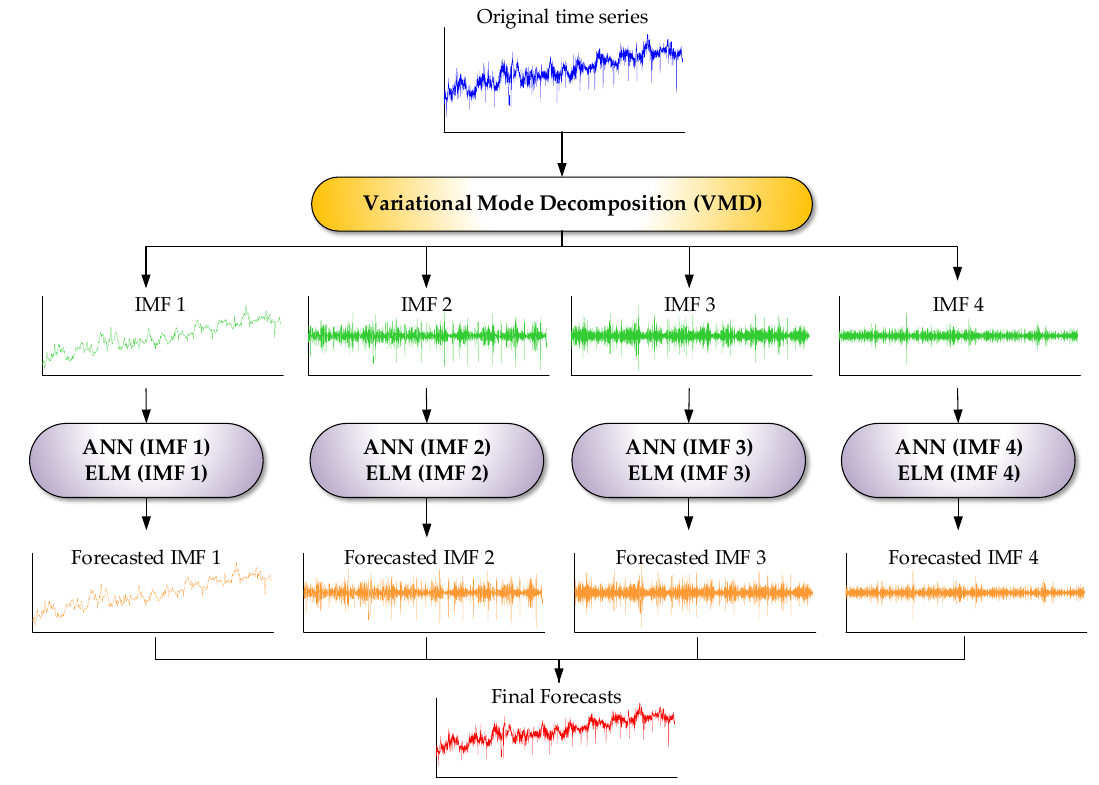
Figure 4. Flowchart for variational mode decomposition (VMD)-based water demand forecasting.